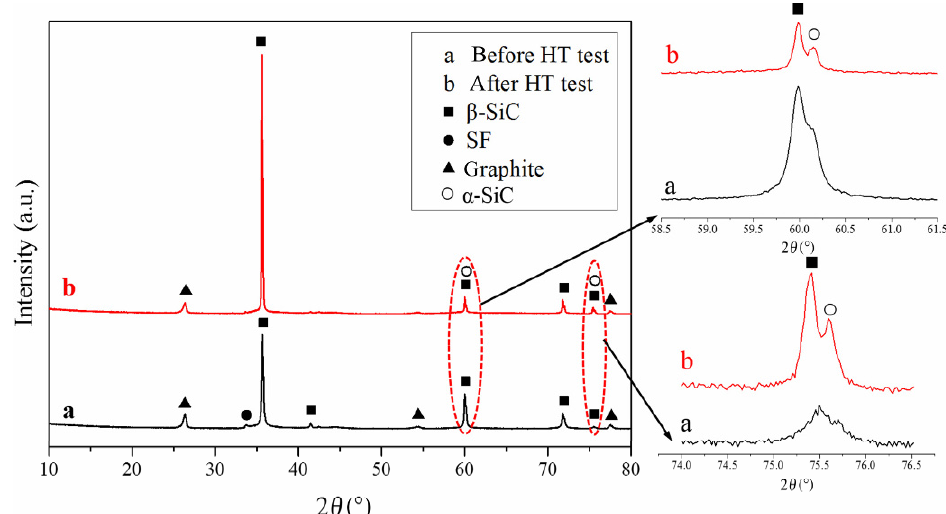
Fig. 12 XRD spectra of the SiC coating before and after HT